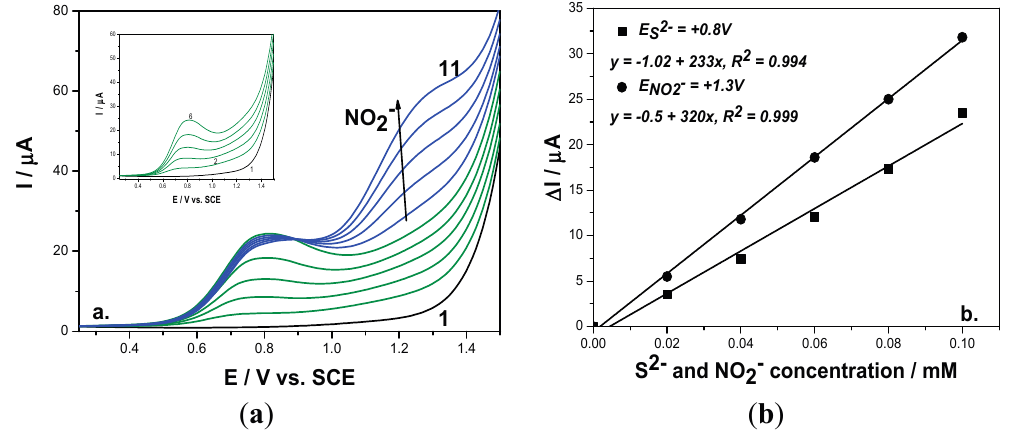
Figure 4. ( a ) Square-wave voltammograms recorded on a BDD electrode under 0.01 V step potential and 0.2 V modulation amplitude, 10 Hz frequency, scan rate 0.1 V·s − 1 , between − 0.25 and +1.5 V vs . SCE in 0.1 M Na 2 SO 4 supporting electrolyte (curve 1) in the presence of 0.02–0.1 mM mixtures of sulfide (curves 2–6; Inset of figure), and 0.02–0.1 mM nitrite (curves 7–11). ( b ) Calibration plots of the current vs .